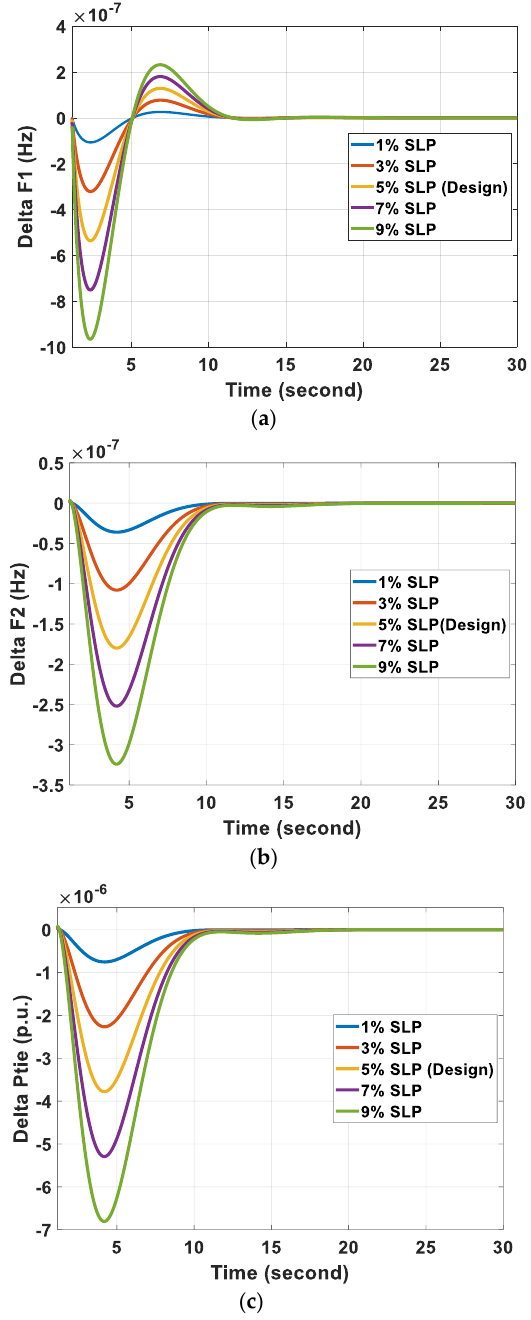
Figure 11. Dynamic response for small SLP based on ULC-fuzzy PIDF controller: ( a ) ΔF 1 , ( b ) ΔF 2 Figure 11. Transient response for small SLP based on ULC-fuzzy PIDF controller: ( a ) ∆ F 1 , ( b ) ∆ F 2 and ( c ) ΔP tie . and ( c ) ∆ P tie